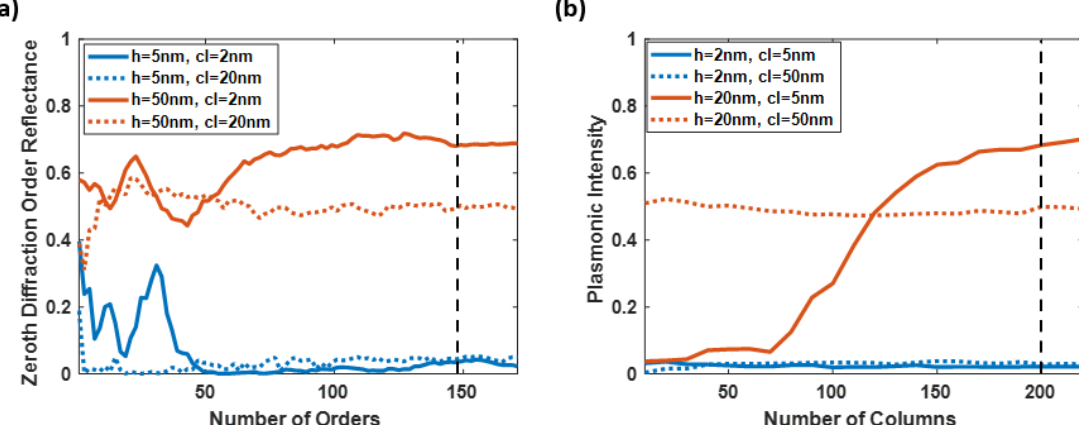
Figure 6. ( a ) The convergence test for the four extreme cases of the rough surfaces constructed with h of 2 nm and cl of 5 nm (solid blue line), h of 2 nm and cl of 50 nm (dashed blue line), h of 20 nm and cl of 5 nm (solid red line), and h of 20 nm and cl of 50 nm (dashed red line), tested with the number of diffractions orders up to 171, and ( b ) The convergence test on the simulated columns for the rough surfaces at the same four extreme cases, illustrated as average plasmonic intensities of the no BSA model, the nonsidewall BSA model, and the sidewall BSA model.